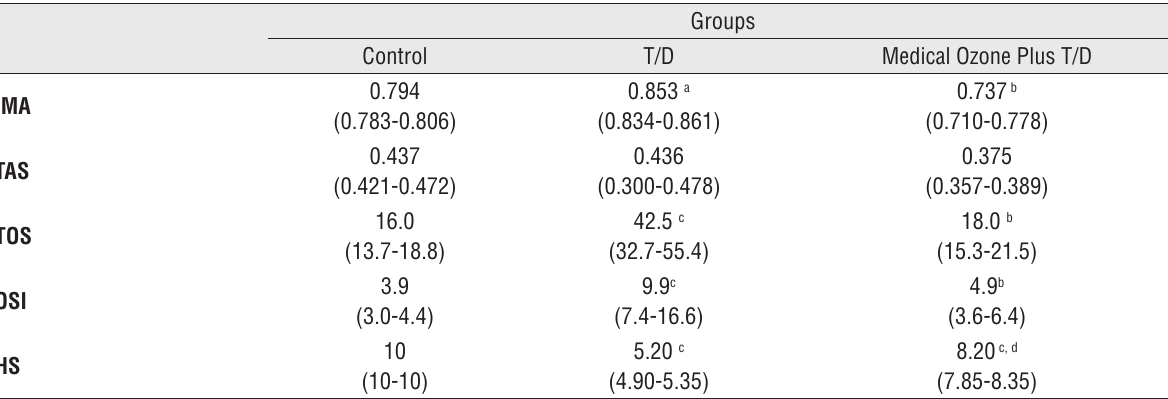
Table 2 - A comparison of biochemical parameters and histopathological scores in the groups.